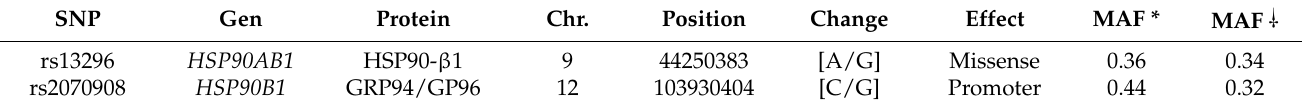
Table 2. SNP’s molecular data.